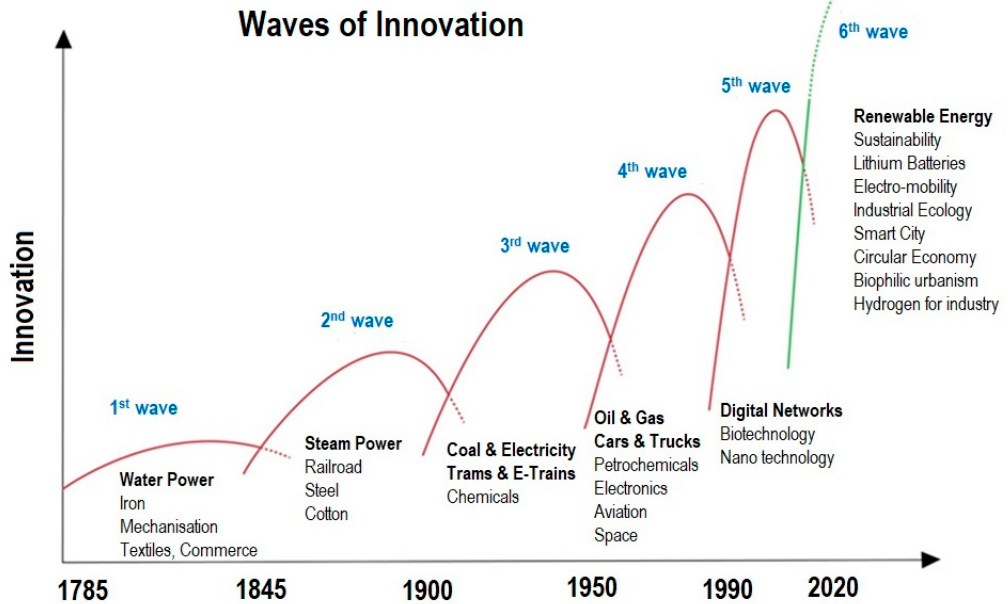
Figure 17. Waves of Innovation following ‘creative destruction’ through industrial history with prospects for the future, reproduced/Adapted with permission from Newman P. [170].